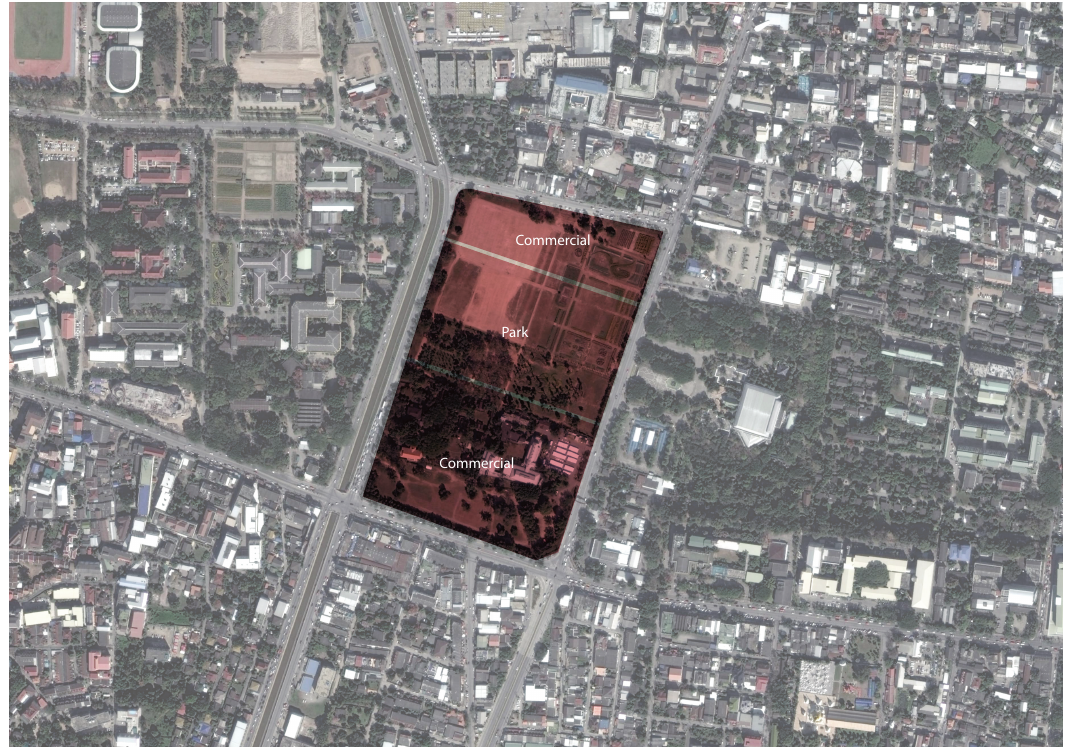
Figure 1. The master plan of CMU square from a newspaper. The figure is adapted from Google R (cid:13) map.